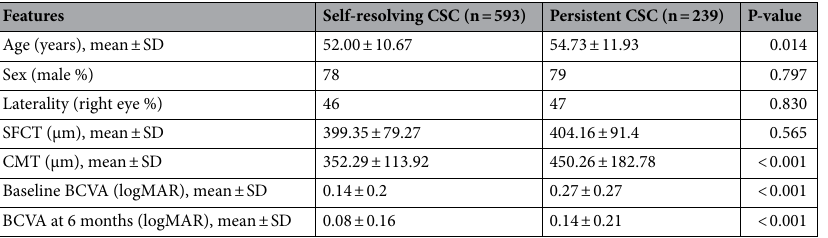
Table 1. Demographic and clinical information of the study participants. CSC: central serous chorioretinopathy; SD: standard deviation; SFCT: subfoveal choroidal thickness; CMT: central macular thickness; BCVA: best-corrected visual acuity; logMAR: logarithm of the minimal angle of resolution.